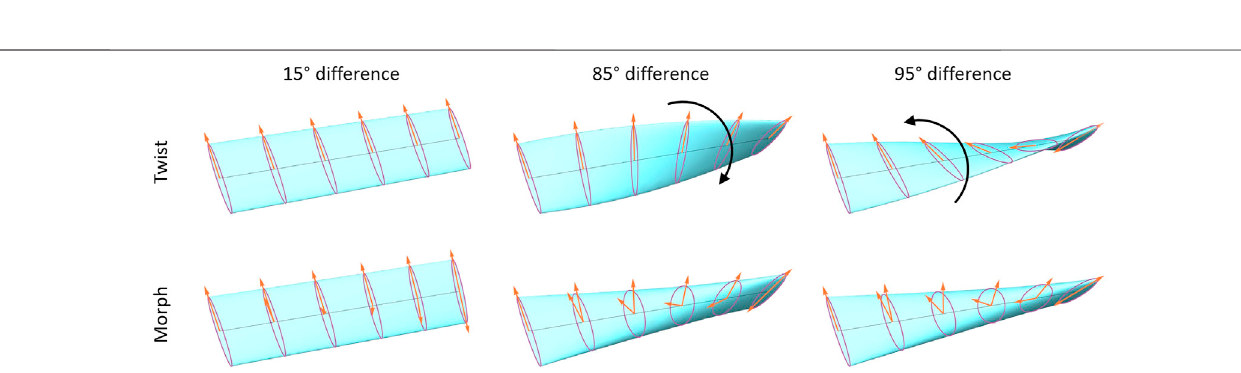
FIGURE 3 | Comparison of rotating elliptical cross sections at angles of (Left to Right) 15 ° , 85, and 95 ° . The top row rotates the normal vector from the initial alignment to the fi nal alignment, exhibiting a fl ip between 85 and 95 ° . The bottom row shows our method, with a circular cross section occurring at angles approaching 90 ° to avoid a discontinuity. Animated versions of this diagram can be found in Supplementary Videos S5, S6 in the supplementary